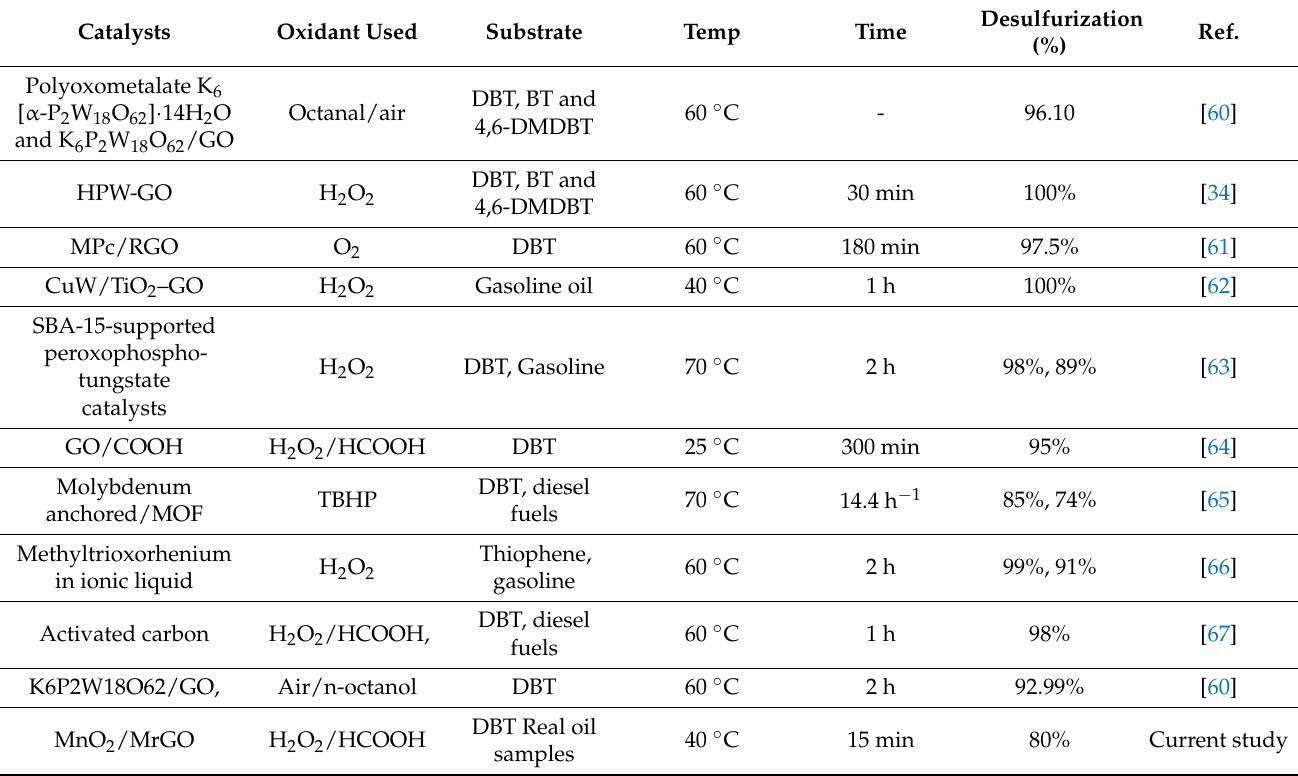
Desulfurization (%)